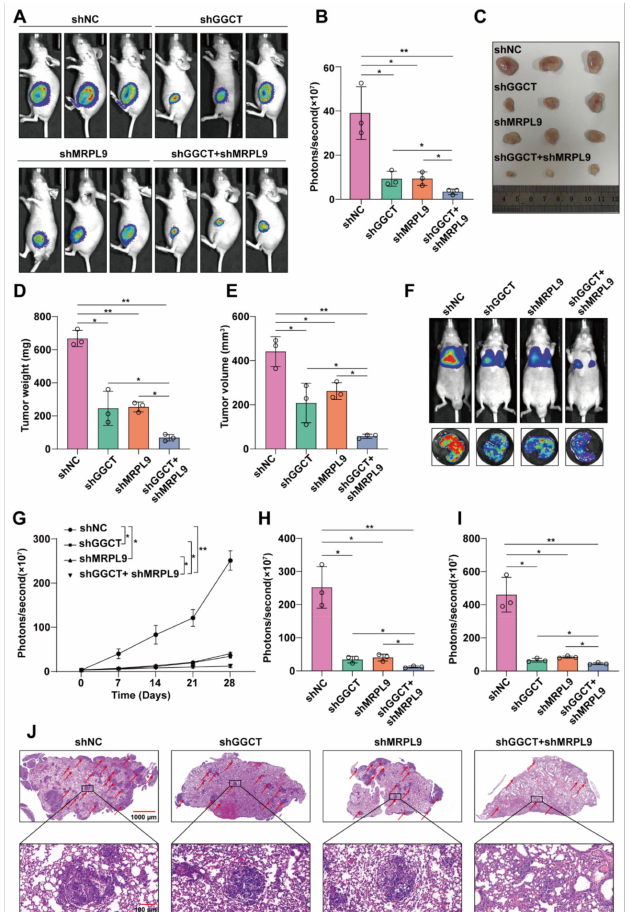
Figure 6. Knockdown of GGCT and MRPL9 inhibited tumor growth and metastasis in vivo. ( A , B ) The Xenogen IVIS Lumina System detects the bioluminescence intensity of subcutaneous xenografts in nude mice in vivo, and performs statistical analysis on the fluorescence signals ( n = 3). ( C ) Subcu- taneous xenografts in nude mice. ( D , E ) Statistical analysis of mass and volume of subcutaneous xenografts ( n = 3). ( F ) The Xenogen IVIS Lumina System detects bioluminescence intensity in the lungs of nude mice in vivo (top) and ex vivo (bottom) ( n = 3). ( G ) The line chart denotes luciferase bioluminescence emitted from the lungs in each group over time (0–28 days). ( H ) Statistical analysis of bioluminescence intensity in the lungs of nude mice in vivo ( n = 3). ( I ) Statistical analysis results of bioluminescence intensity of nude mouse lung tissue in vitro ( n = 3). ( J ) HE staining was used to analyze the metastases in the lungs of nude mice. Measurement data (mean ± standard deviation) between two groups were compared by paired t test, and multiple groups were compared by one-way analysis of variance (ANOVA). “**” represents p ≤ 0.01, “*” represents p ≤